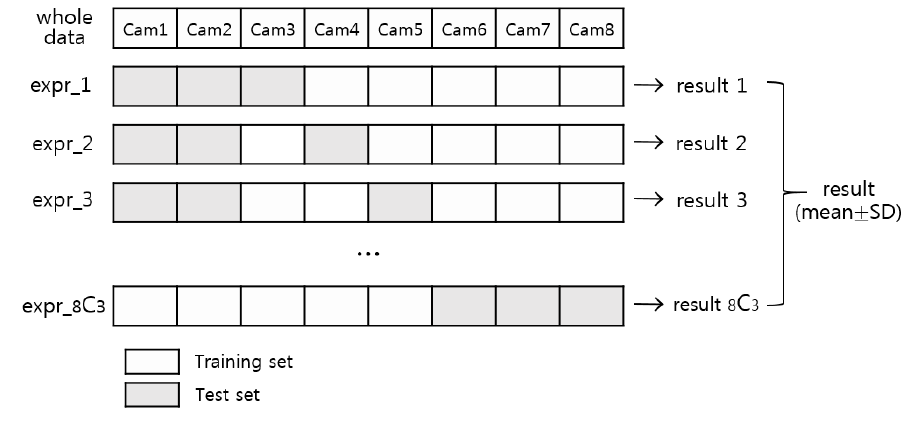
Figure 5. Schematic view of leave-pair-out cross validation.